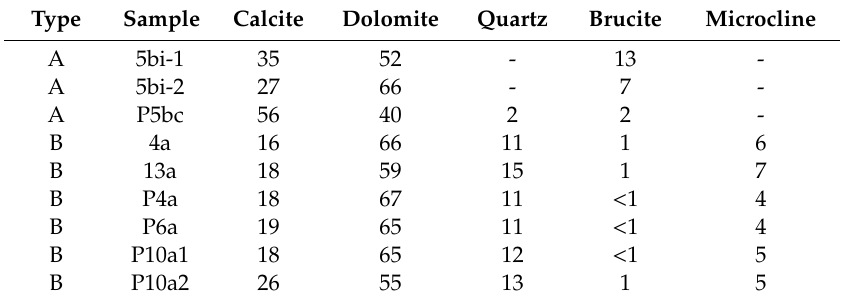
Table 2. Mineralogical composition of the paste from type A (convectional) and type B concrete (with sand-cement).